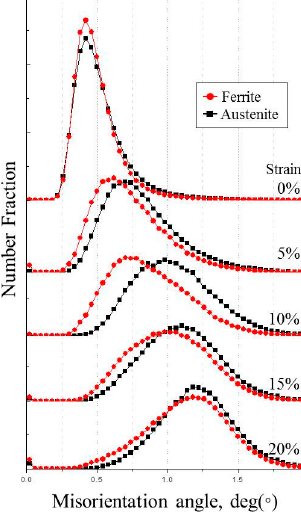
Figure 3. EBSD Kernel average misorientation (KAM) distribution of 0–20% strained